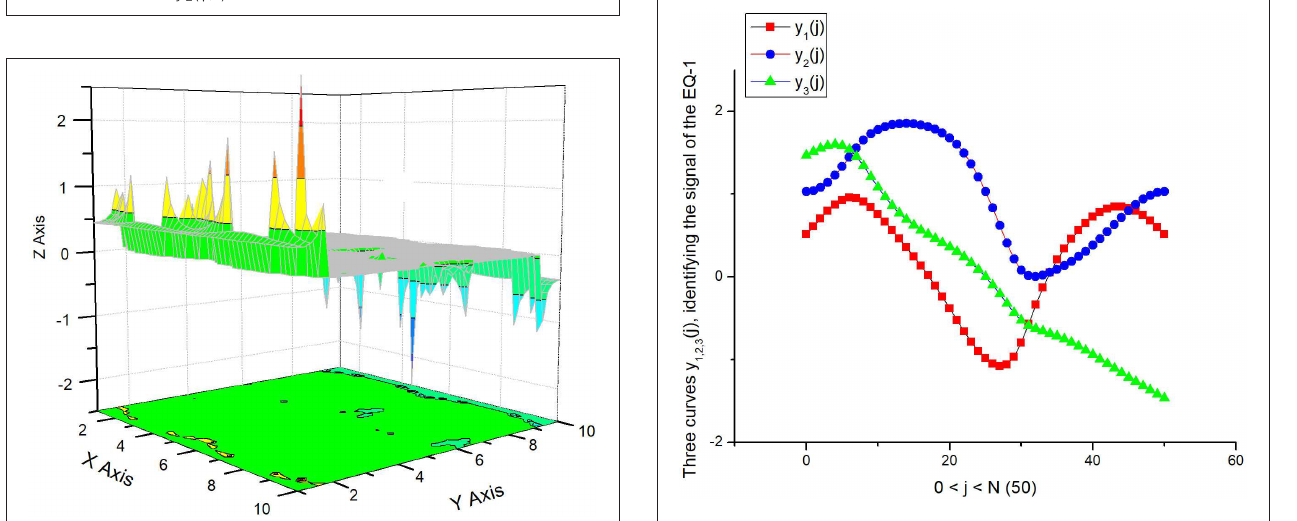
FIGURE 7 | This figure corresponds to the surface Z = y 2 ( ϕ , θ ) for the trans-number E . The scale for the angles ϕ [OX axis] and θ [OY axis] is kept the same. Each angle is digitized as X Axis = ϕ j = 2 π · ( j /10), Y Axis = θ j = π · ( j /10), j = 0,1,…,10. This figure should be compared with Figure 3 , where the same surface Z = y 2 ( ϕ , θ ) for the trans-number π is shown.